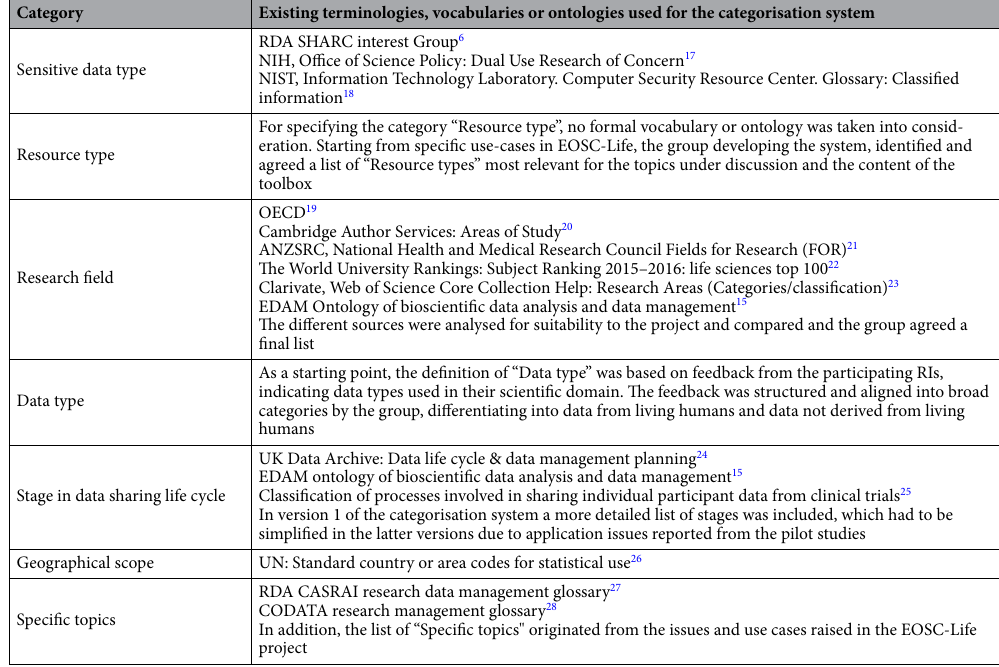
Table 2. Terminologies, vocabularies and ontologies used in the development of the categorisation system. Here only the categories from version 3 are considered. In version 1 two more categories “research design 29–34 and “targeted group [35] were considered but not included in the final version